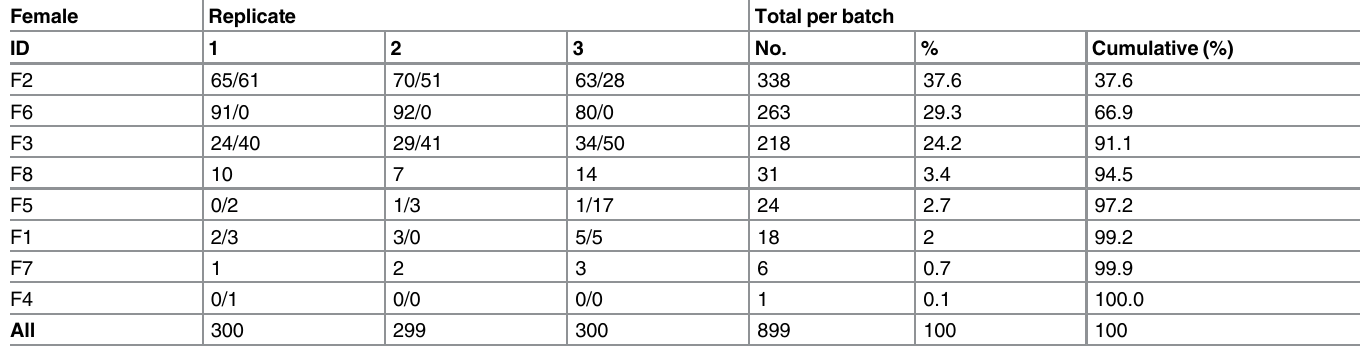
Table 4. Parental contribution to post-metamorphosis progeny, for the three replicate tanks (where applicable divided into contributions from each of two males; Table 1) and total over all three tanks. Female Replicate Total per